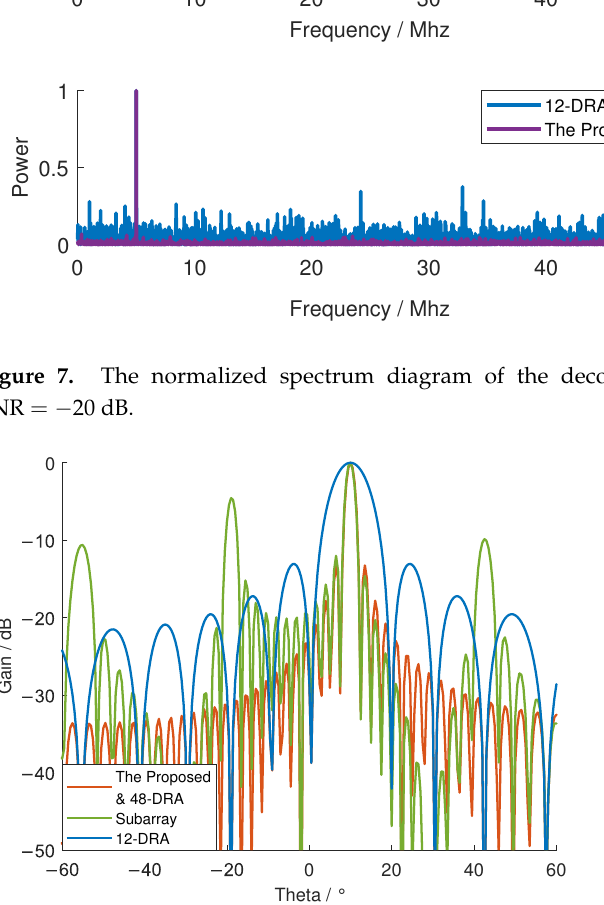
Figure 8. The normalized array pattern of different DBF